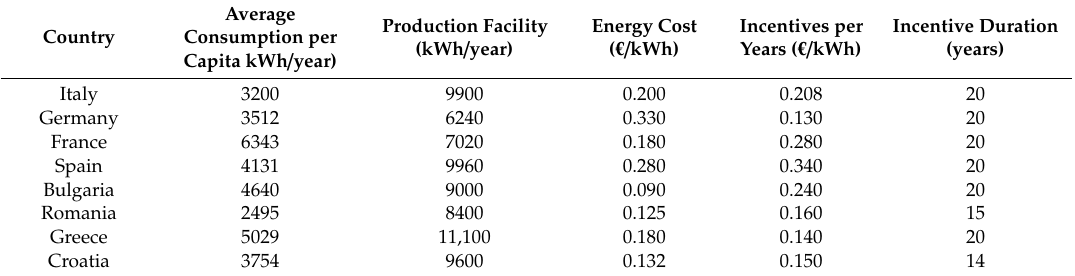
Table 15. Economic data of the reference countries reproduced from [20], reproduced from proceedings of the 2018 International Conference on Smart Grid, IEEE: